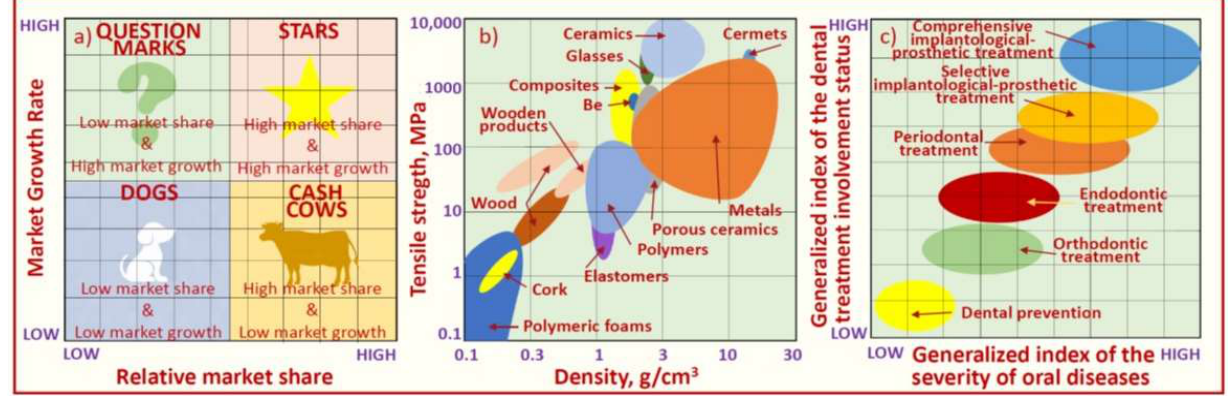
Figure 8. Contextual matrix schemas: ( a ) BCG for market assessment; ( b ) properties of various groups of engineering materials, the so-called “Maps of M.F. Ashby”; ( c ) an original concept of the matrix of advancement and treatment of oral diseases.